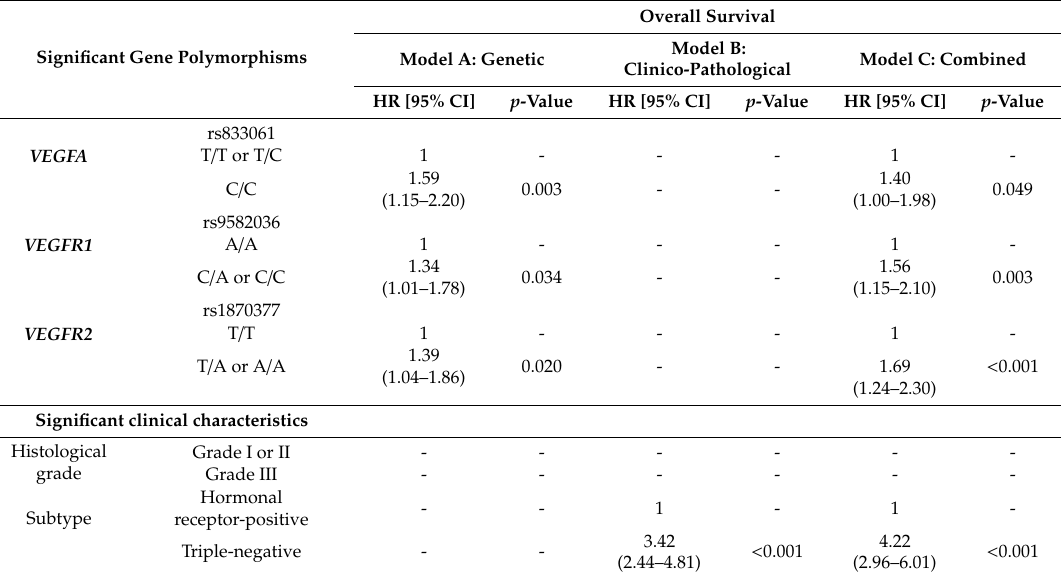
Table 4. Multivariate analysis according to